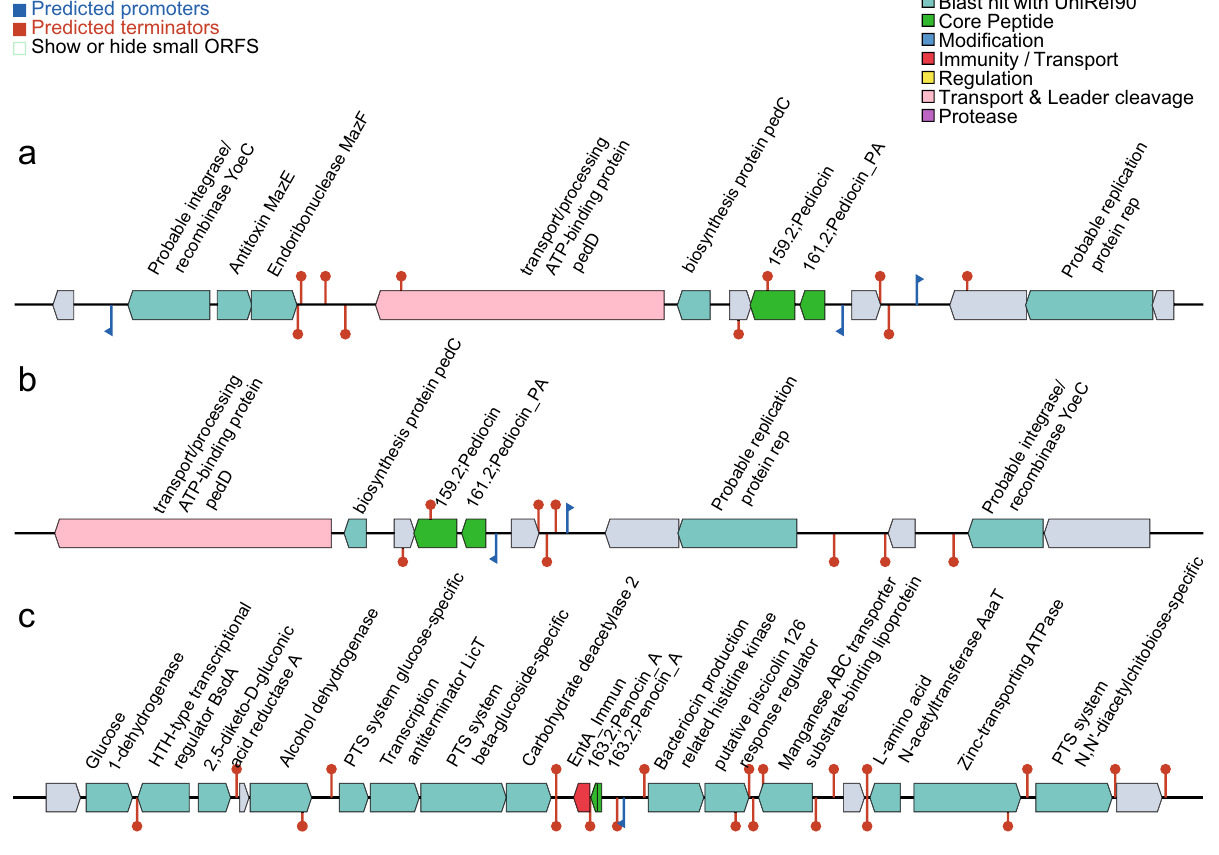
SCG) also observed in all compared genomes. However, P. pentosaceus ST75BZ and ST87BZ strains have 142 unique genes (Supplementary Table 4). Based on the pangenomes of our isolates against reference genomes, we propose P. pentosaceus ST31BZ as a new strain of P. acidilactici and strains ST75BZ and ST87BZ as a new strain of P. pentosaceus . The two